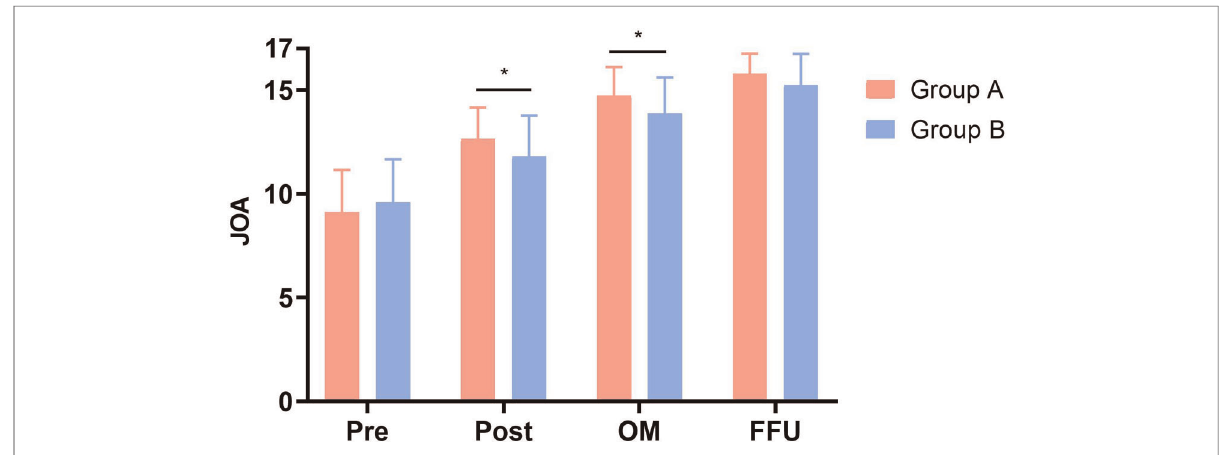
FIGURE 1 Comparison of JOA scores between two groups. Pre, preoperative; Post, postoperative; OM, one month after surgery; FFU, fi nal follow-up. *Signi fi cance between the two groups, P